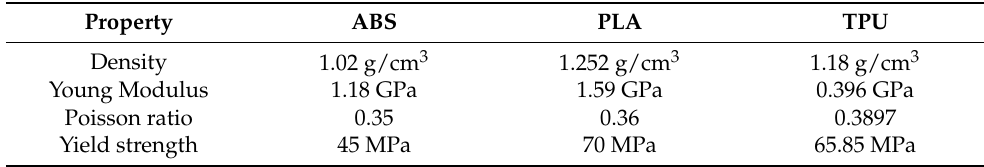
Table 2. Properties of materials used in the